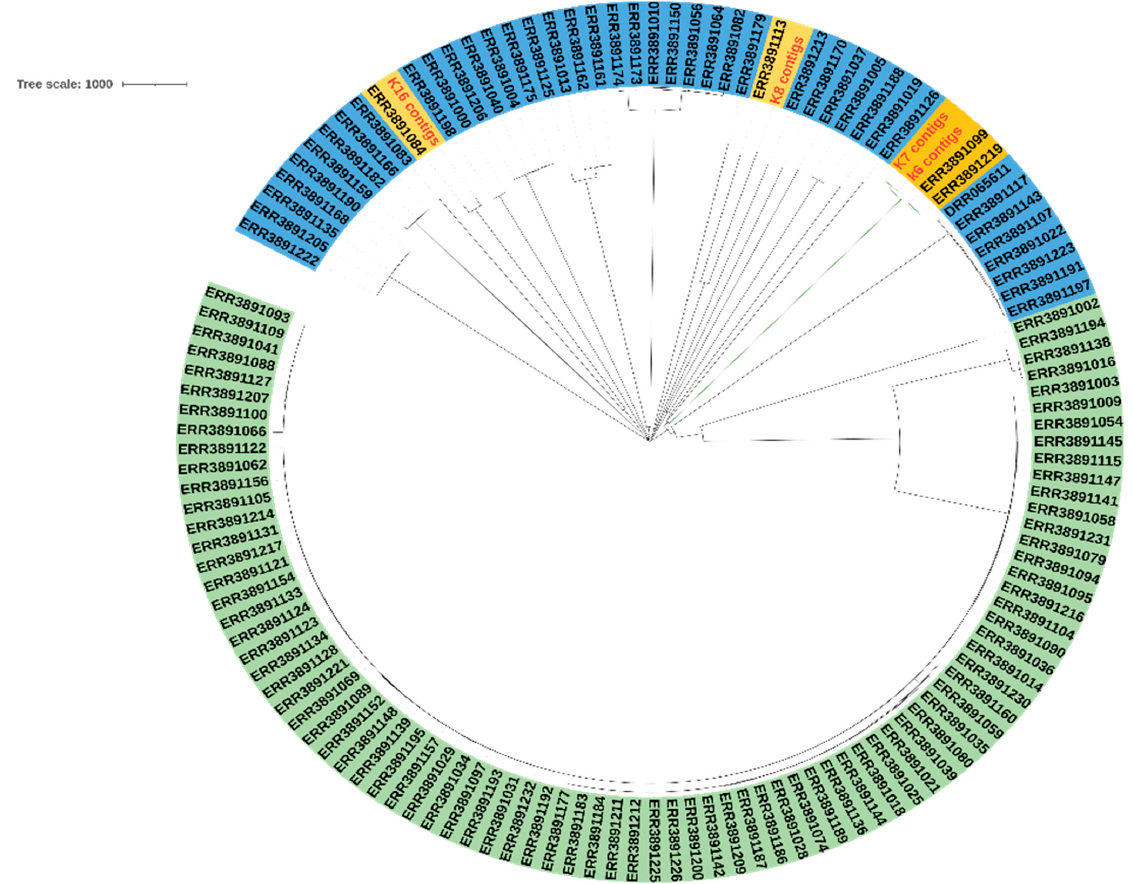
Figure 6. Phylogenetic analysis of our isolates (in red colors) compared to the most similar strains of K. pneumoniae isolated from Saudi Arabia. The most similar isolates are highlighted in yellow.